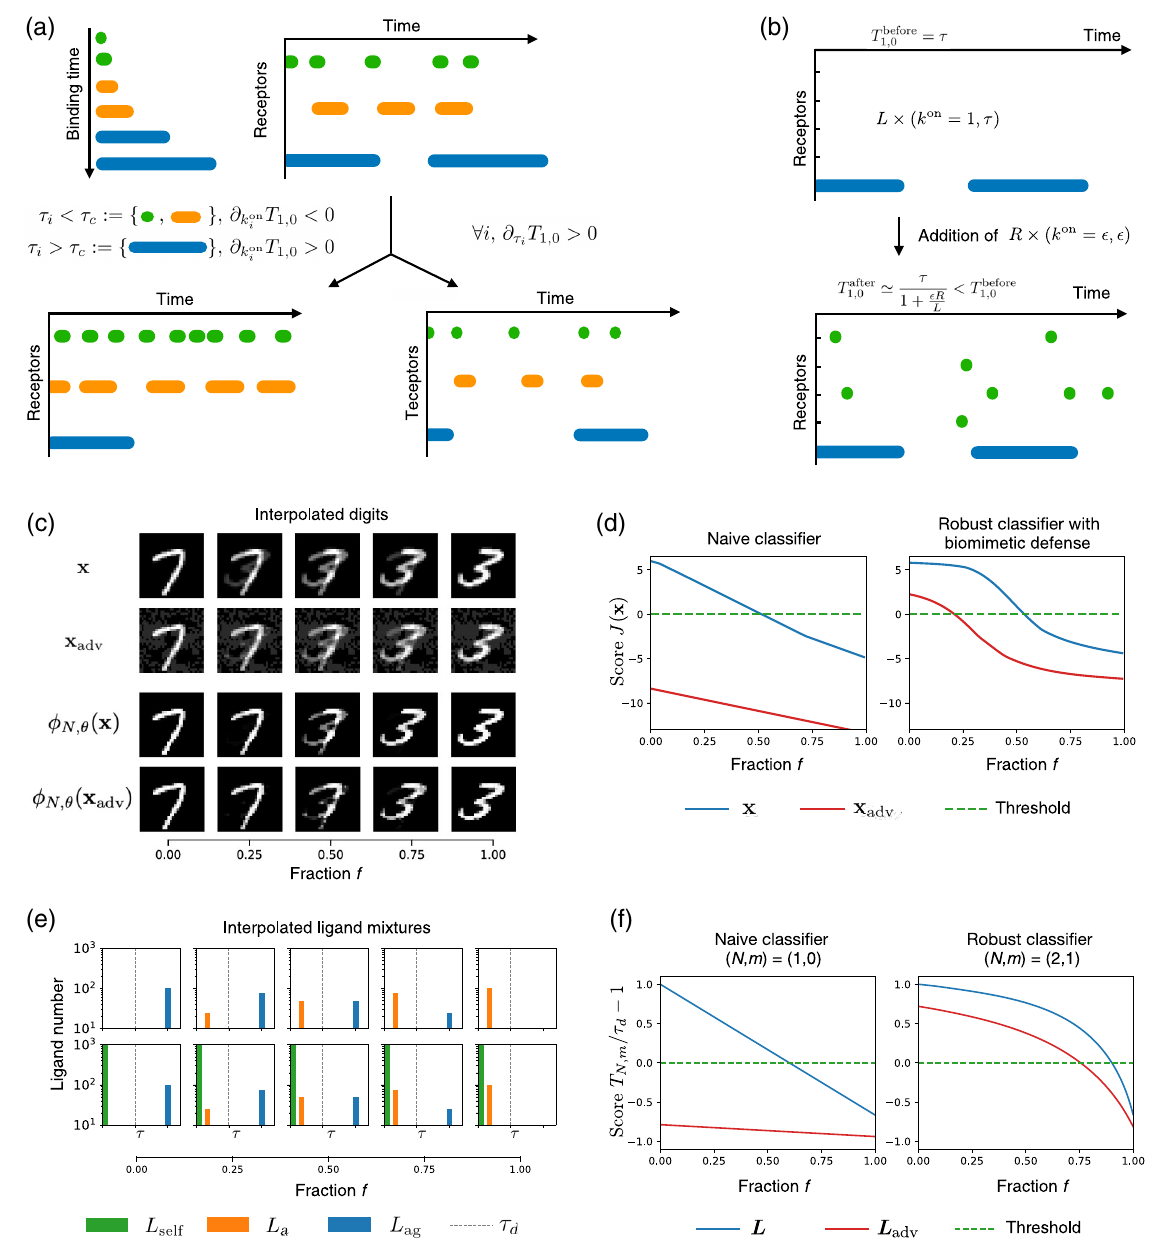
FIG. 3. Schematics of FGSM applied to immune recognition. (a) We compute how to lower the response for the receptor occupancy through a given period of time by changing k on i and τ i . Bottom left: Increasing k on i for ligands with τ i < τ d and decreasing k on i for ligands with τ i > τ d reduces the weighted average T 1 ; 0 (change in frequency of the colored bars). Bottom right: Decreasing τ i for all ligands decreases T 1 ; 0 (change in length of the colored bars). (b) Response to nonself-ligands is lowered from T before 1 ; 0 to T after 1 ; 0 upon addition of R ligands with small binding time ϵ . (c) Interpolated digits with and without adversarial perturbation along the interpolation axis between ⃗ 3 ⃗ 7 ( f ¼ 0 ) and ( f ¼ 1 ). Adversarial perturbations are computed via the FGSM with ϵ ¼ 0 . 2 . For the biomimetic defense ϕ ð N; θ Þ , we choose N ¼ 5 and θ ¼ 0 . 5 . (d) Scoring function J ð x Þ on pictures of (c) without (left) and with (right) the biomimetic defense. The classification threshold is indicated by the dashed green line at J ¼ 0 . Samples with J > 0 are classified as 7, otherwise 3. (e) Interpolated ligand mixtures with and without self-ligands along the interpolation axis between agonist ( f ¼ 0 ) and antagonist ; τ 100 ; 6 Þ ; ð L ; τ 100 ; 1 Þ ; ð L ; τ 1000 ; 0 . 1 Þ . (f) Scoring function on ligand mixtures of (e) for a ( f ¼ 1 ). Here, ð L a a Þ ¼ ð ag ag Þ ¼ ð self self Þ ¼ ð naive immune classifier ð N; m Þ ¼ ð 1 ; 0 Þ (left) and a robust immune classifier ð N; m Þ ¼ ð 2 ; 1 Þ (right). The threshold is indicated by a dashed green line at T N;m = τ d − 1 ¼ 0 . T N;m = τ d − 1 > 0 corresponds to the detection of agonists and below corresponds to no detection. In both digit recognition and ligand discrimination, the naive networks interpolate the score linearly and are sensitive to adversarial perturbations, while the score for robust networks is flatter, closer to the initial samples for longer, thus, more resistant to